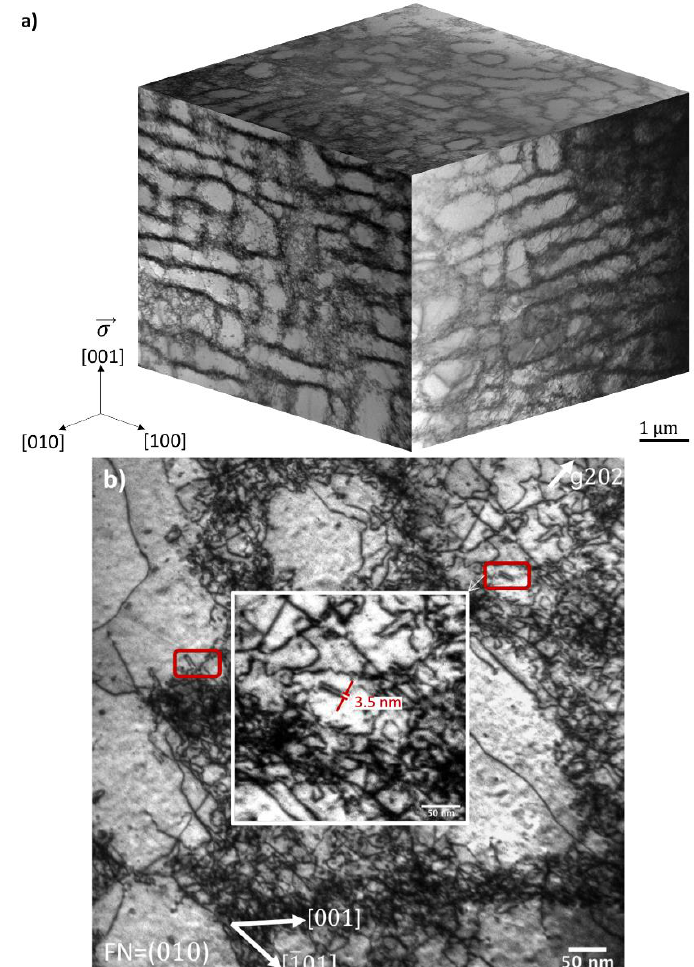
Figure 3. ( a ) Transmission electron microscope “cube” based on images taken from the (100), (010), and (001) planes of a specimen cyclically deformed to saturation as illustrated in Figure 1. The stress axis is parallel to the vertical direction [001]. ( b ) A part of the labyrinth structure showing dislocation dipoles.